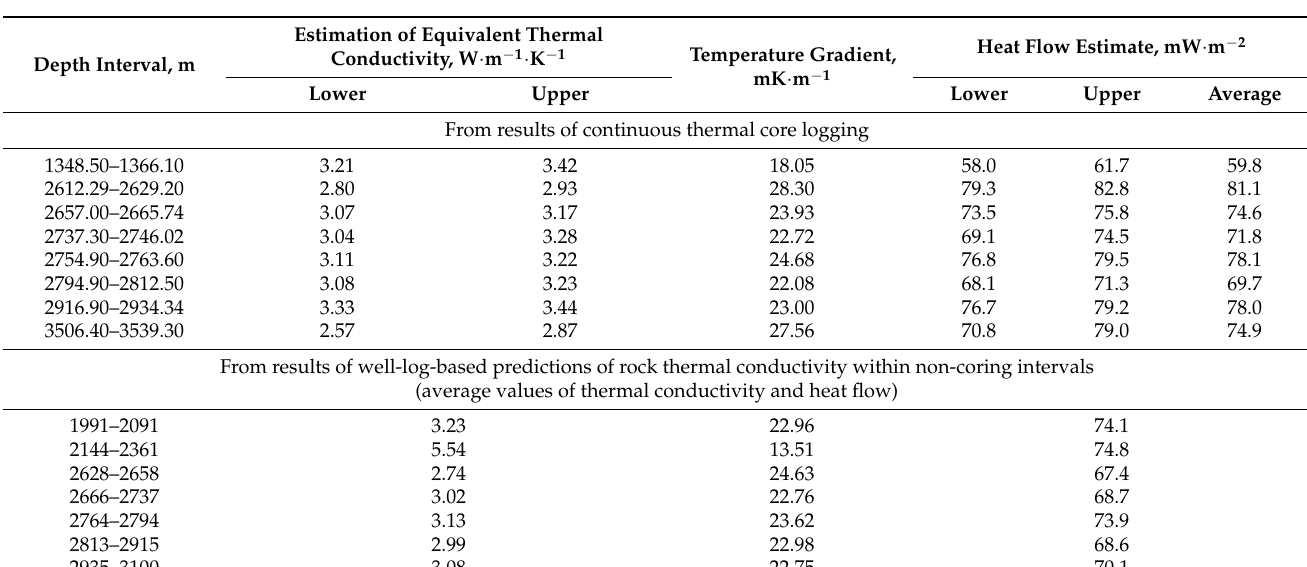
Table 8. Results of determining equivalent thermal conductivity and heat flow density for coring depth intervals and intervals with well-log-based predictions of rock thermal conductivity within non-coring intervals.